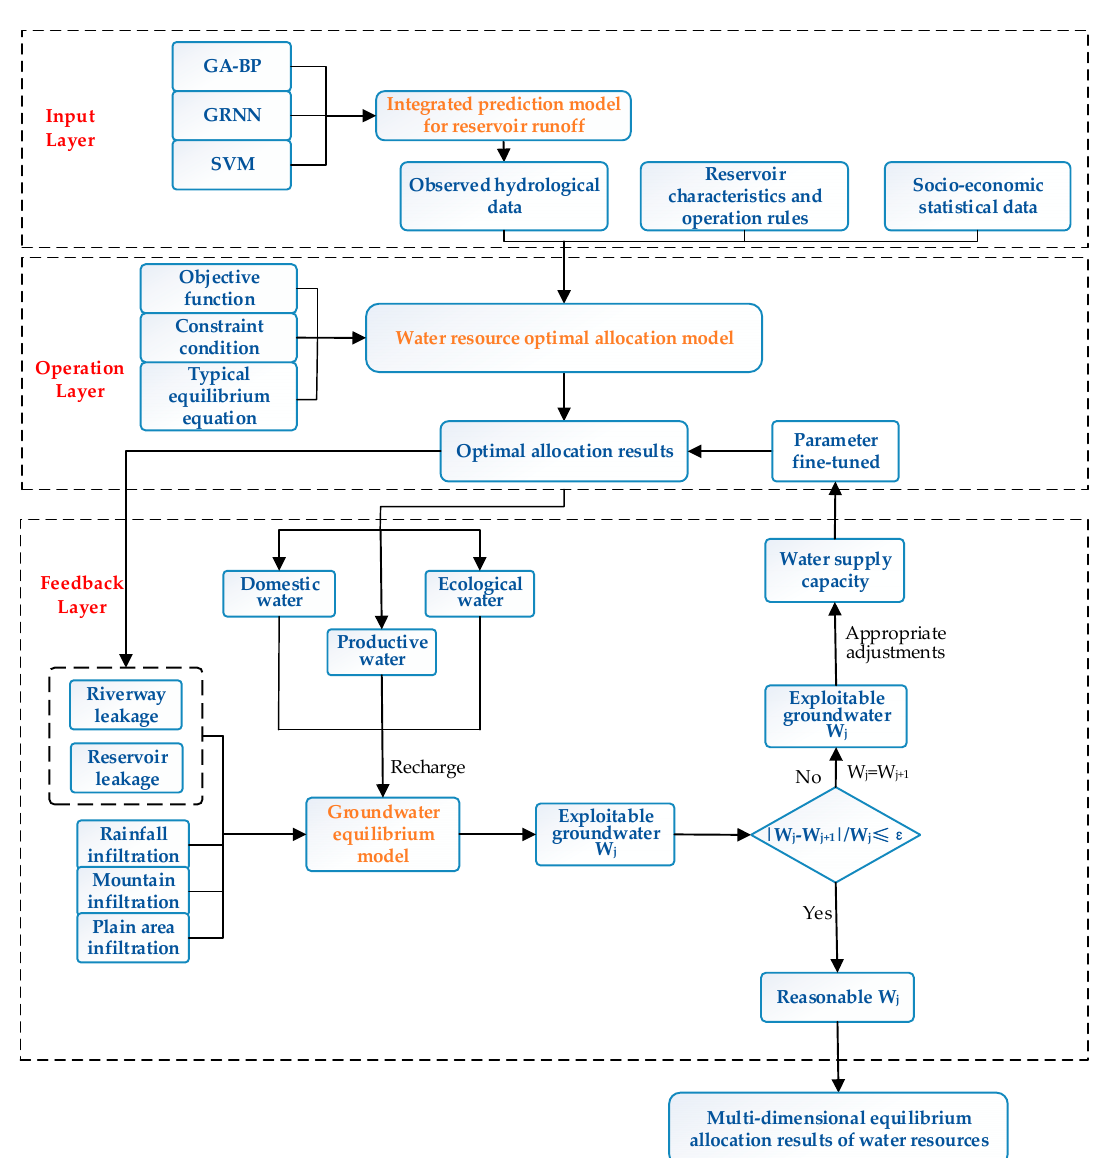
Figure 1. Study framework for multi-dimensional equilibrium allocation model of water resources. GA-BP: genetic algorithm-back propagation; GRNN: general regression neural network; SVM: support vector machine.